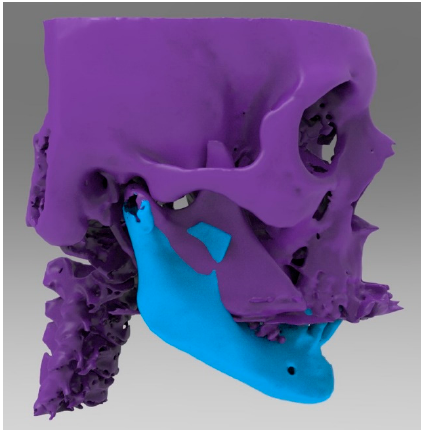
Figure 4. The preintervention computerized tomography (CT) was superimposed with the post CT in order to determine the original position of the mandible.